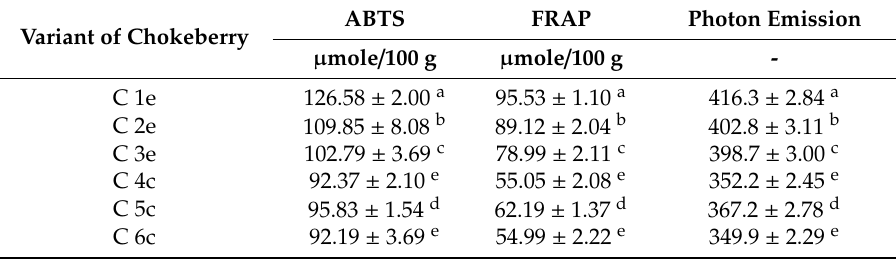
Table 2. Antioxidant activity and ultra-weak luminescence black chokeberry fruits. Variant of Chokeberry